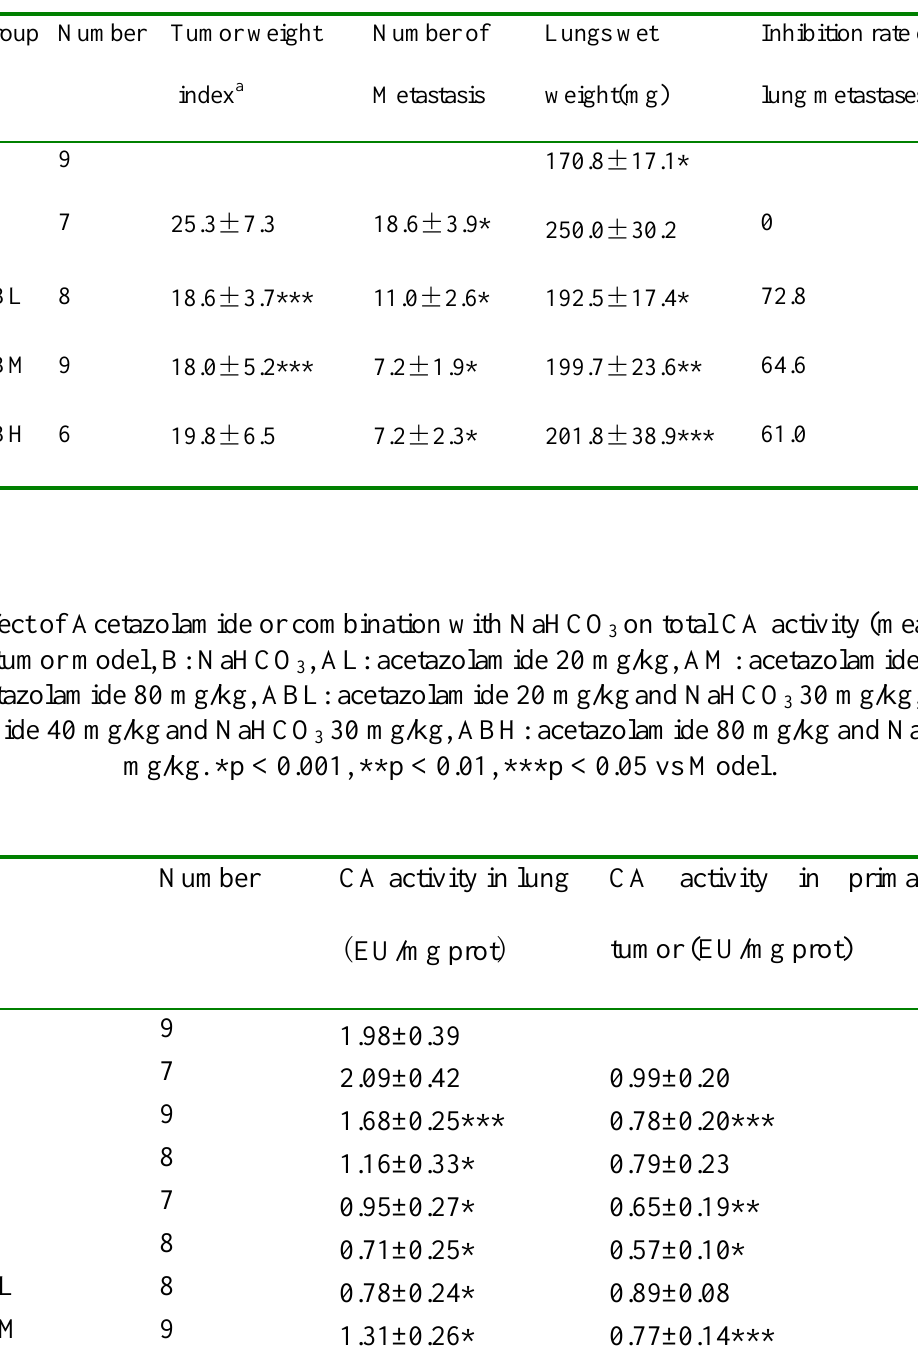
Table 1. Effect of acetazolamide treatment with NaHCO on experimental tumor growth and 3 metastasis in mice (mean ± SD). Acetazolamide and NaHCO i.g. were used for 21days. C: normal , 3 M: tumor model, ABL: low dose of acetazolamide at 20 mg/kg and NaHCO 30 mg/kg, ABM: 3 acetazolamide at medium dose of 40 mg/kg and NaHCO 30 mg/kg, ABH: high dose of acetazolamide 3 at 80 mg/kg with NaHCO 30 mg/kg. a Tumor weight index means the ratio of tumor weight to body 3 weight (g/g) × 100. b Inhibition rate of lung metastases = Model-Treatment/Model-Control(lung wet